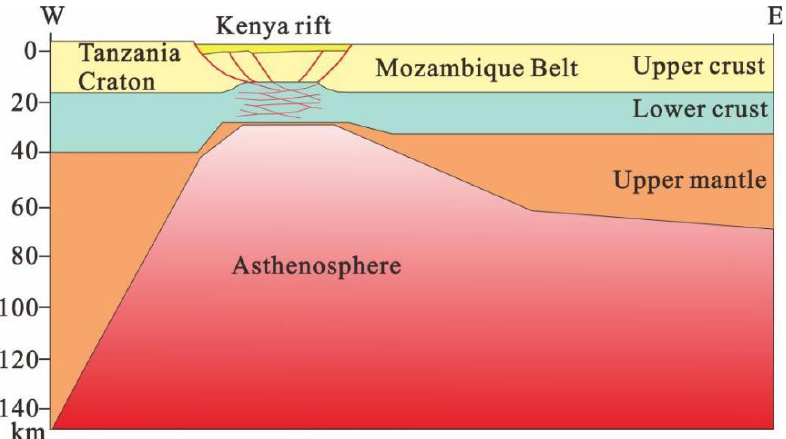
Figure 1. Composite lithospheric E-W cross-section of the Kenya rift, modified from Hetzel et al. [7]. The sub-horizontal thin red lines represent the anastomosing shear zones in the lower crust.